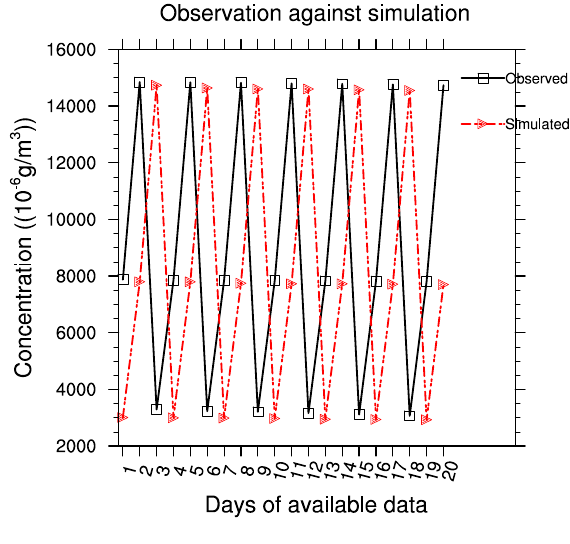
concentration against x